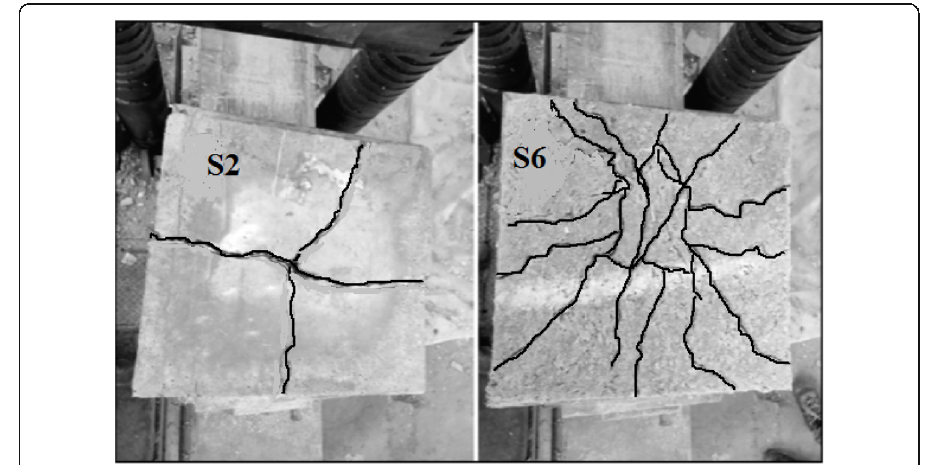
Fig. 8 Cracking patterns for S2 and S6 after 3 cycles of loading and